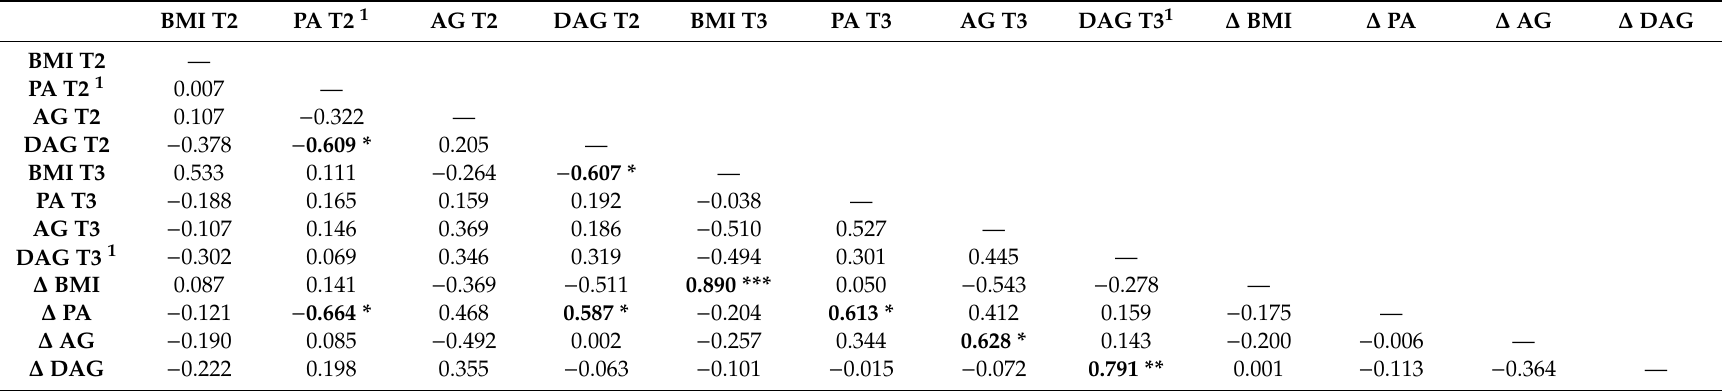
Table 2. Correlations between BMI, physical activity, AG and DAG plasma concentrations in the clinical samples after weight restoration and one-month post